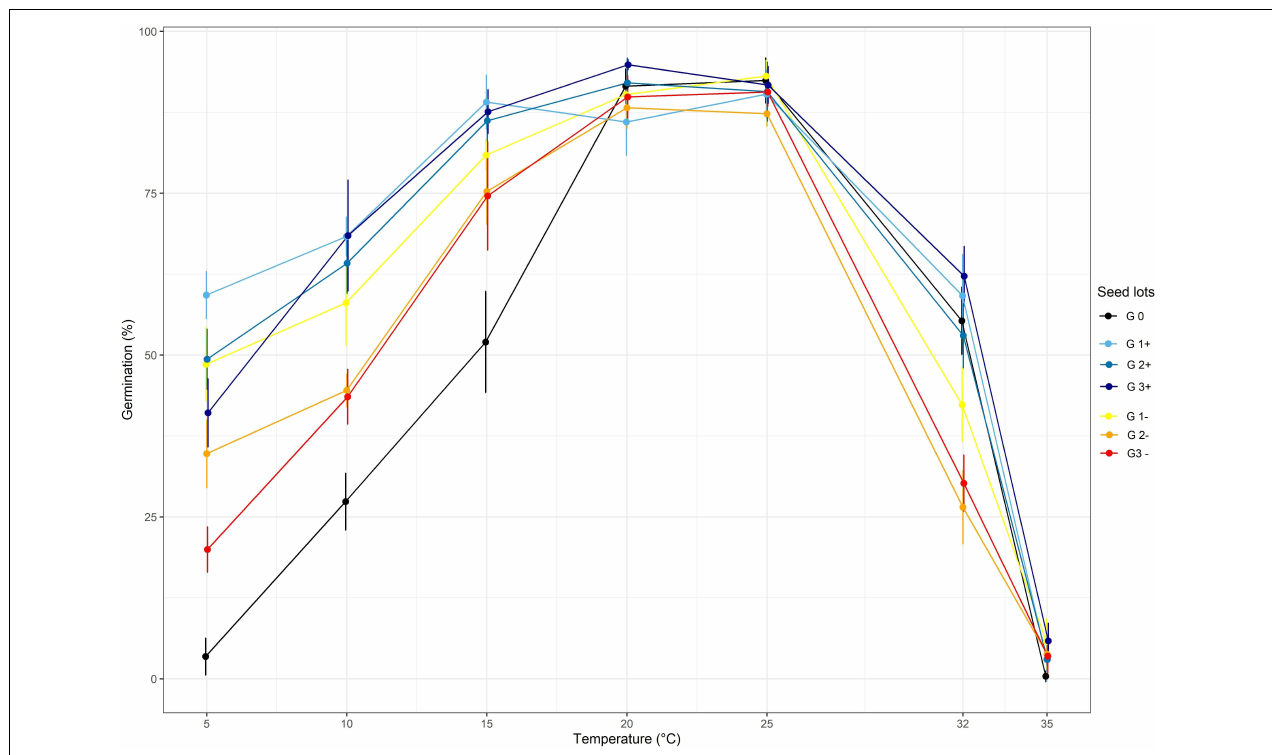
FIGURE 4 | The effect of divergent selection at 10 ◦ C on the seed germination percentage of all the populations obtained from positive selection (G1+, G2+, G3+) and negative selection (G1-, G2-). G0 corresponds to the initial population.